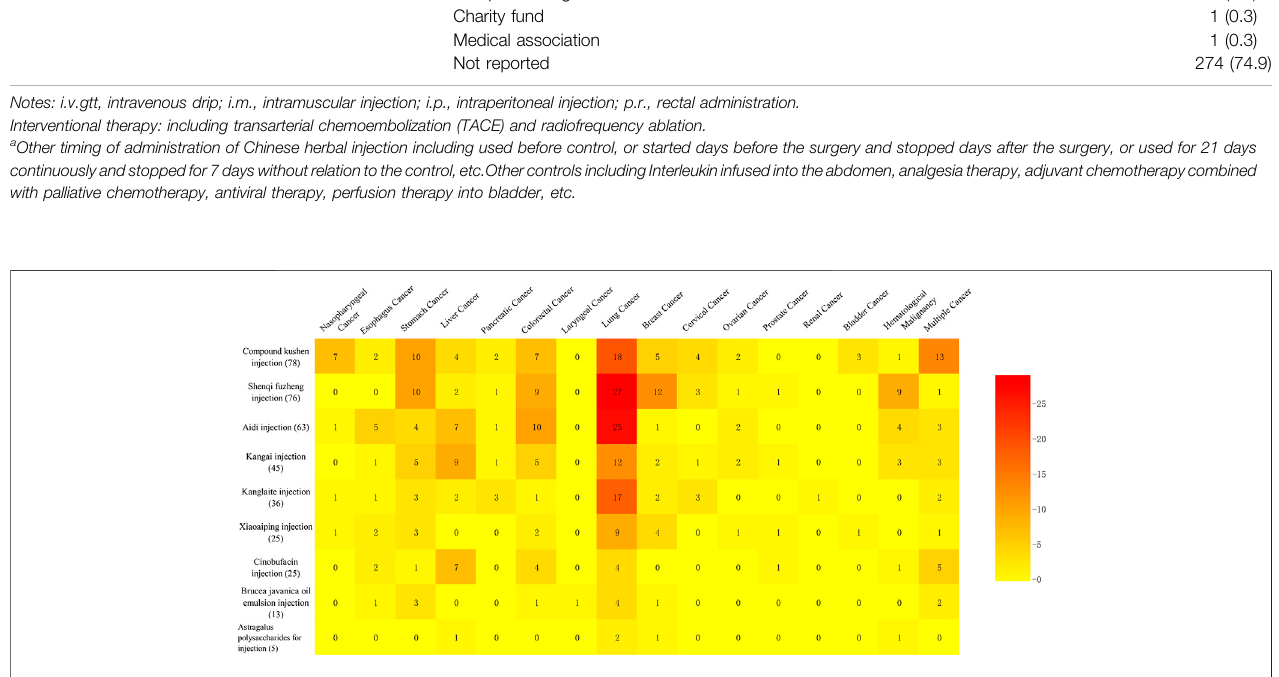
FIGURE 3 | Evidence mapping of the distribution of nine herbal injections by cancer